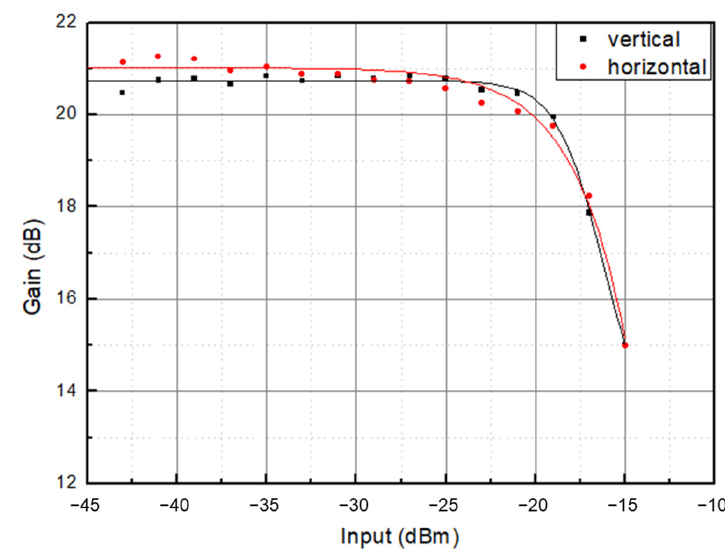
Figure 2. Gain of OA according to polarization and optical input power.